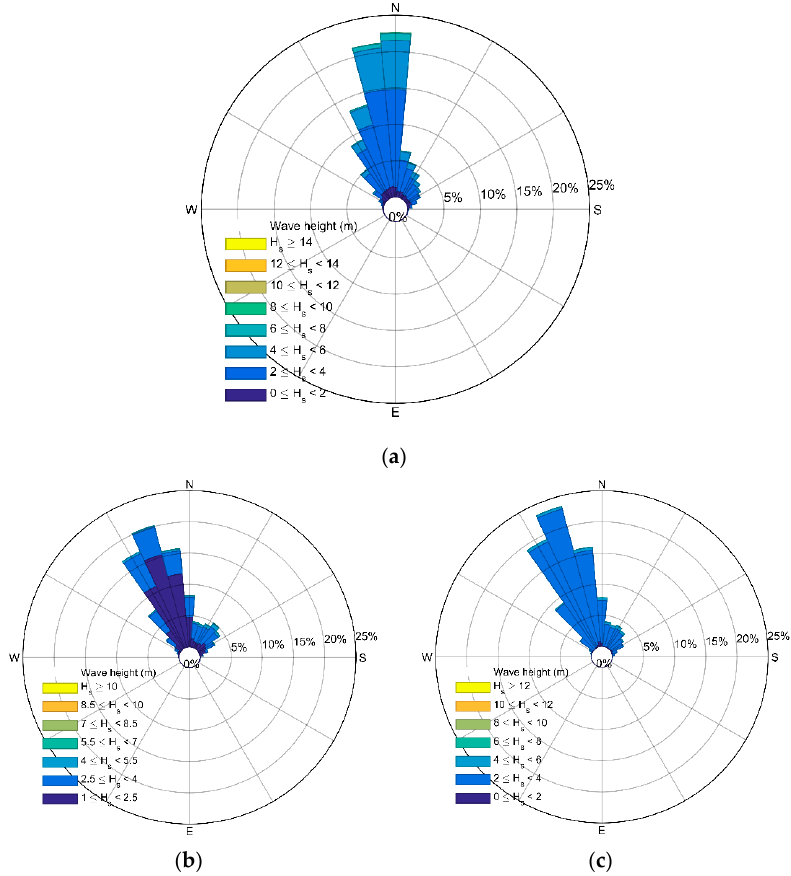
Figure 3. Mean wave direction for the control points (Figure 2b) for ( a ) the historical (1979–2005), ( b ) near future (2026– 2045), and ( c ) far future (2081–2099) periods. ( b ) near future (2026–2045), and ( c ) far future (2081–2099)